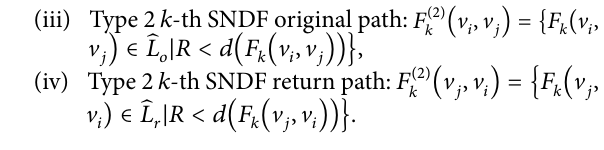
Figure 3: An example of Type 1